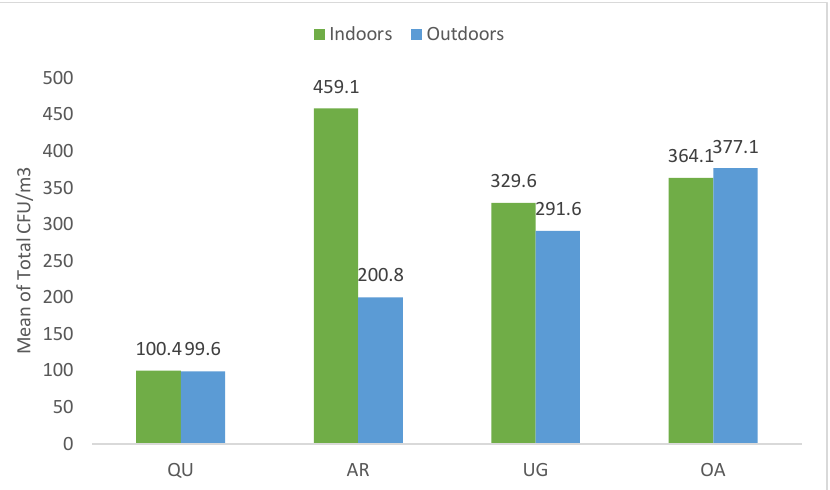
Figure 3. The mean of total indoor and outdoor airborne bacterial concentration (CFU/m 3 ) at all health centers.